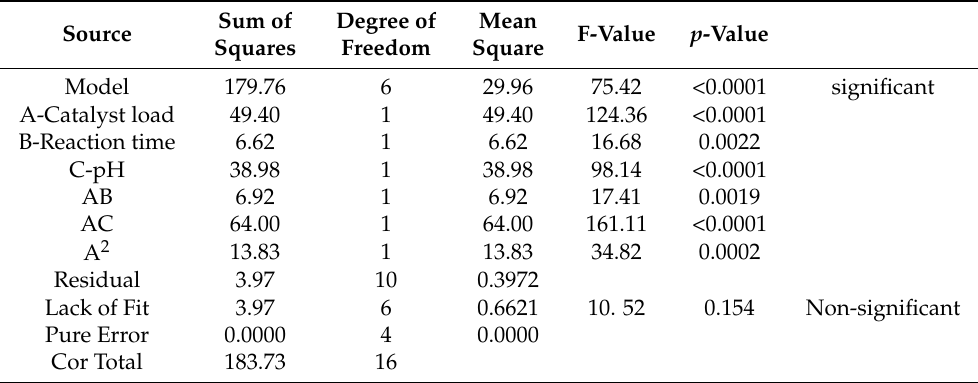
Table 5. Analysis of variance (ANOVA) results for the turbidity quadratic